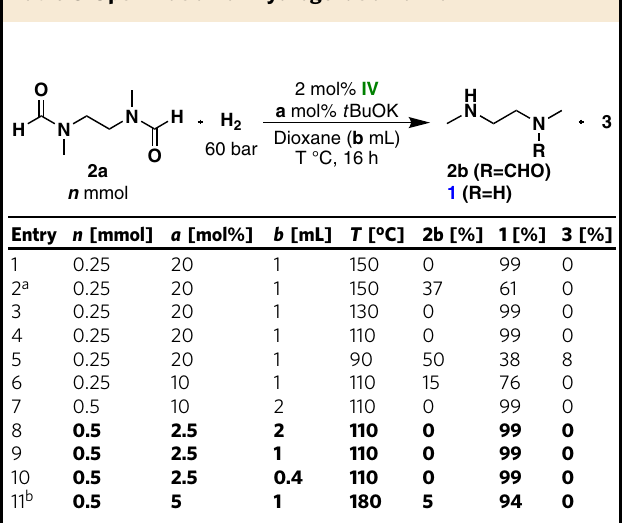
Table 3 Optimization of Hydrogenation of 2a.